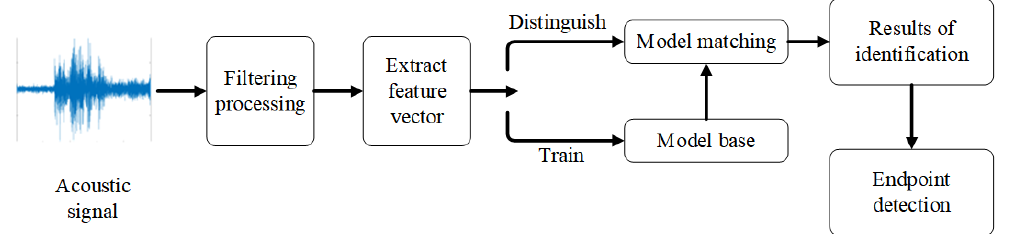
Figure 1. Flow chart of thunder recognition used in the present study.